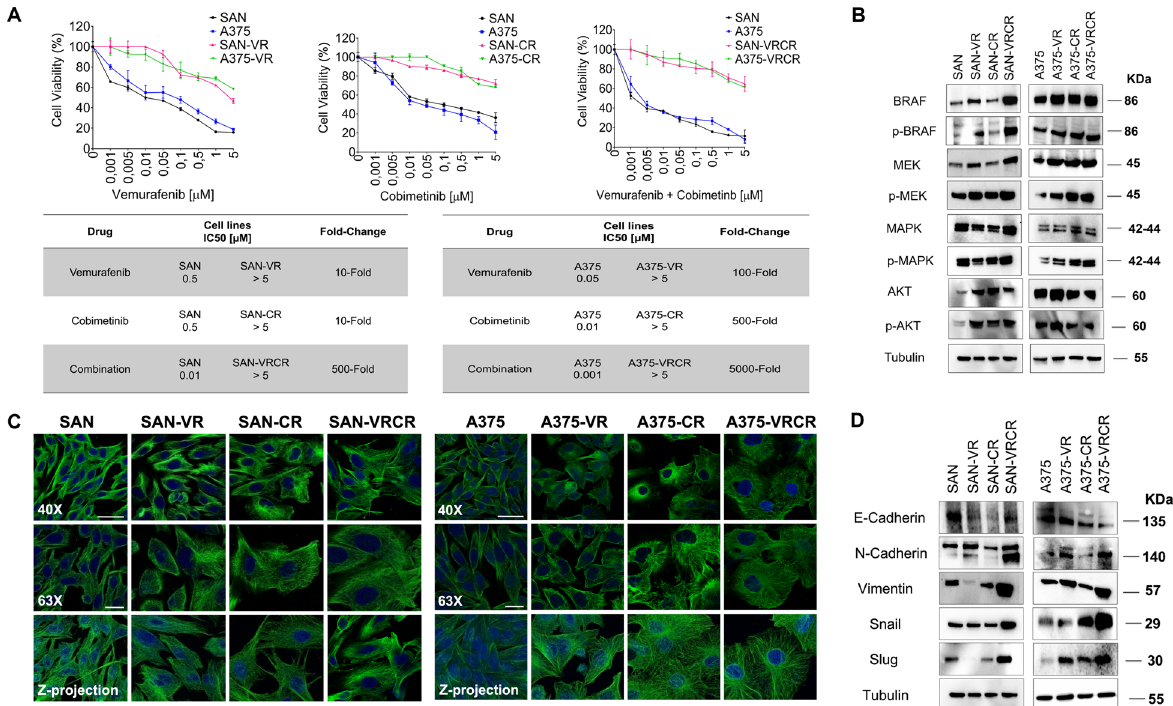
Fig. 1 Development and characterization of vemurafenib and/or cobimetinib-resistant melanoma cell lines. A Parental and resistant cell lines were treated with increasing concentrations of vemurafenib, cobimetinib and their combination (0.001–5 µg/mL) for 72 h and then evaluated for proliferation by MTT staining. The table summarizes IC 50 values and the relative fold-change in resistant versus parental cell lines. B Protein expression and phosphorylation levels of parental and resistant cell lines determined by western blot analysis in basal condition. C Confocal images of parental and resistant cell lines showing different tubulin organization. Different colors are applied to improve visualization: nuclei (DAPI) are in blue and microtubules in green. Scale bar for 40X objective: 20 μm; for 63X: 10 μm; maximum projection of Z-stack sections. D Expression level of proteins involved in epithelial-mesenchymal transition was detected by Western